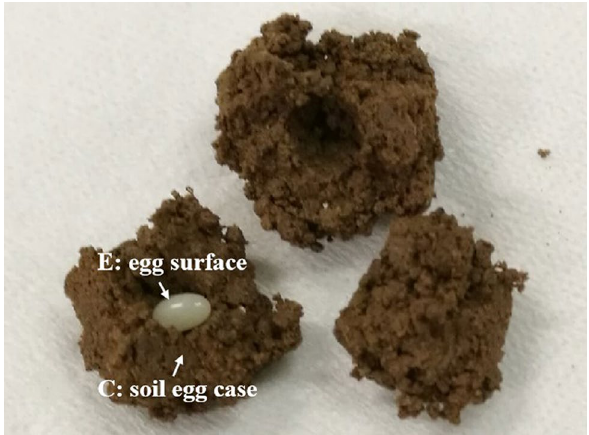
Figure 1. Photograph of the SEC structure and egg of H. oblita . SEC (C) samples and egg surface (E) samples were collected as shown in the Figure, and bulk soil (B) samples were collected from the soil about 10 cm away from the egg